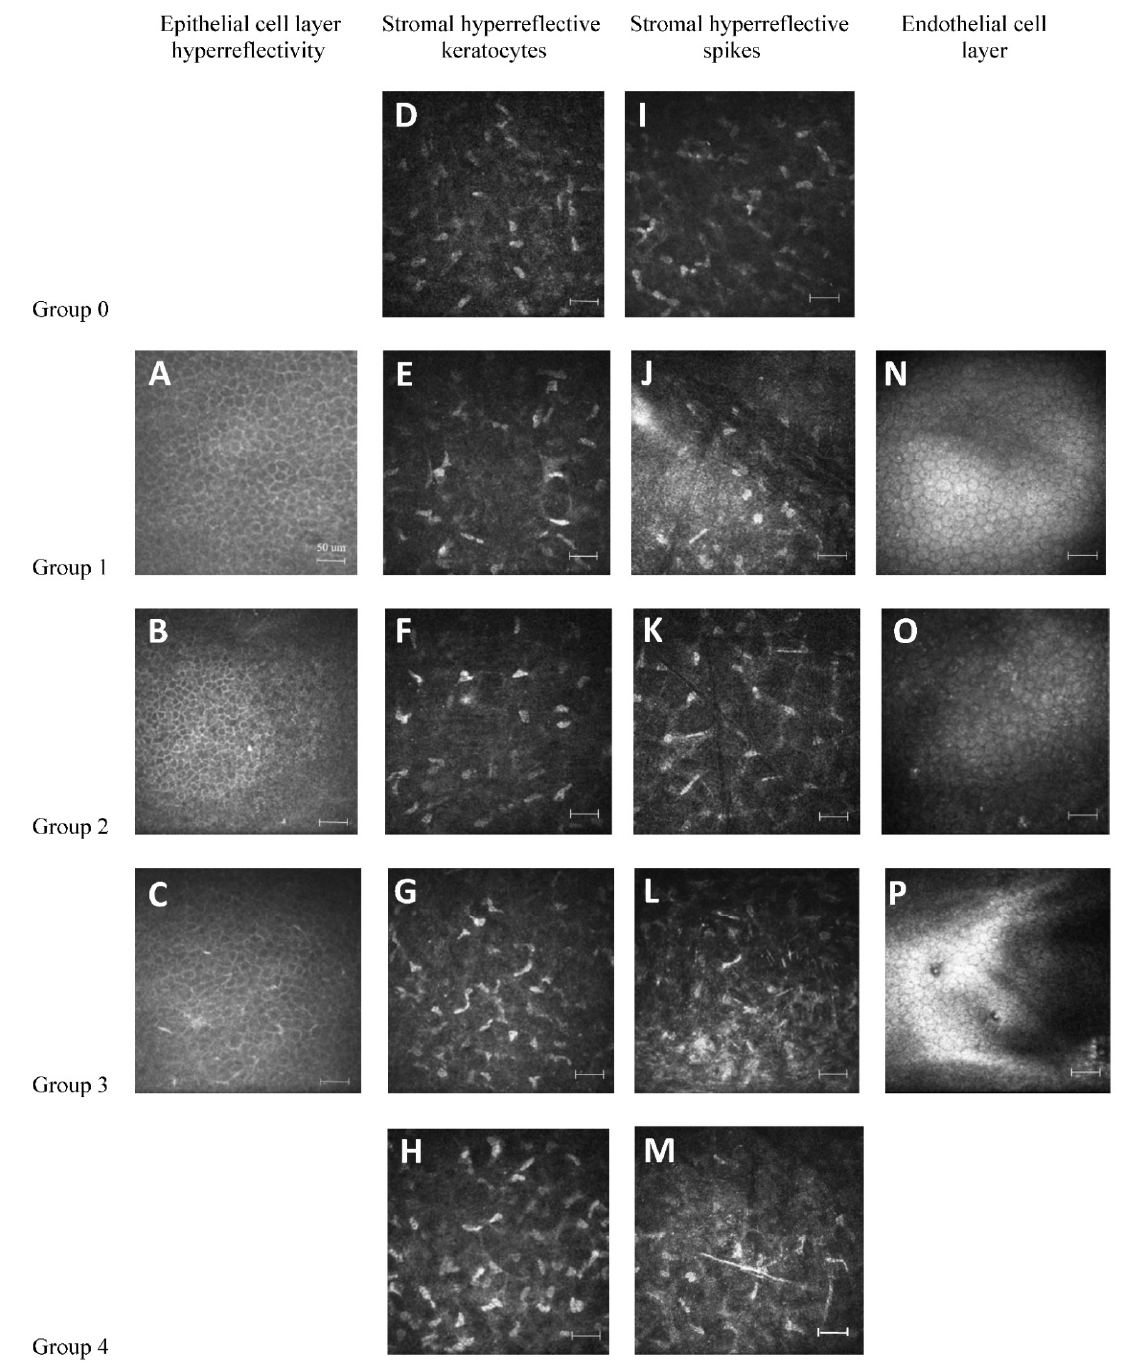
Figure 1. Classification of epithelial cell layer properties ( A – C ), stromal hyperreflective keratocytes ( D – H ), stromal hyperreflective spikes ( I – M ) and endothelial cell layer properties ( N – P ) using vivo confocal laser scanning cornea microscopy (IVCM) imaging with Heidelberg Retina Tomograph, with Rostock Cornea Module (HRTII/RCM) (Heidelberg Engineering, Heidelberg, Germany), as described at Table 1. We used a classification modified from Aragona et al. [ [54]. Scale bars: 50 µ m. For statistical analyzis of the data, the Mann–Whitney U test and the χ 2 test were used, with p values below 0.05 considered statistically